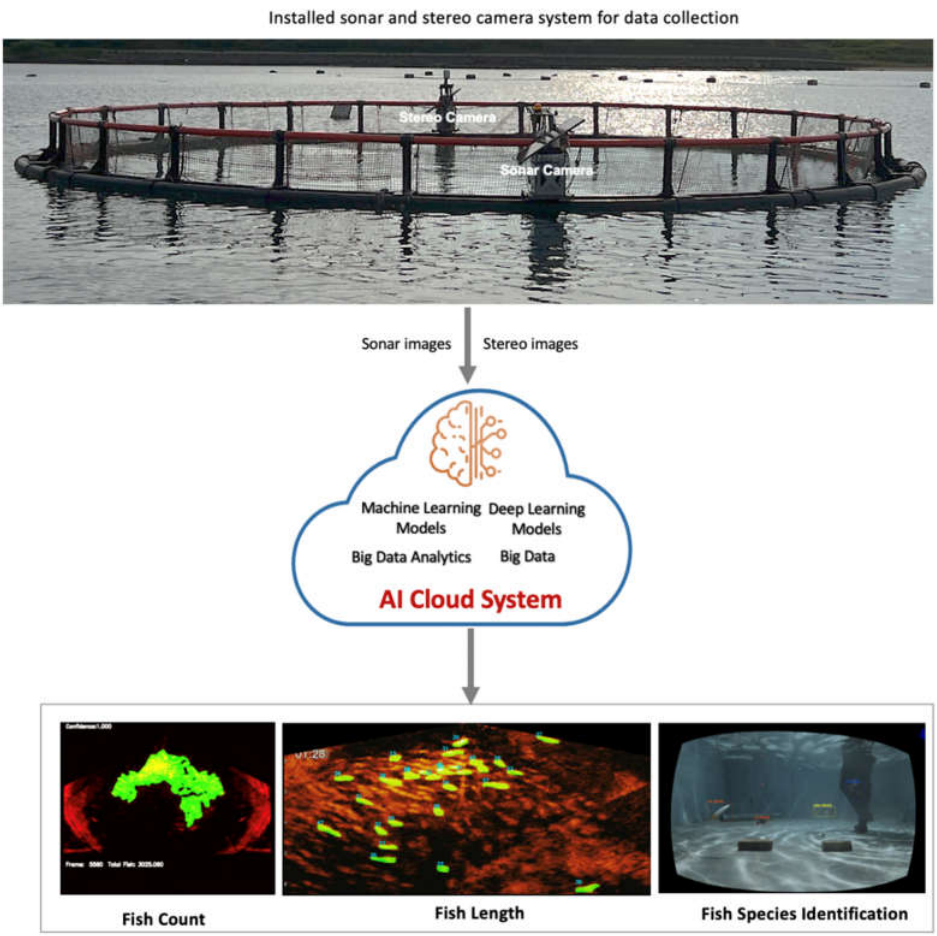
Figure 2. The framework of our proposed AIoT technology for smart Underwater surveillance for precision aquaculture.